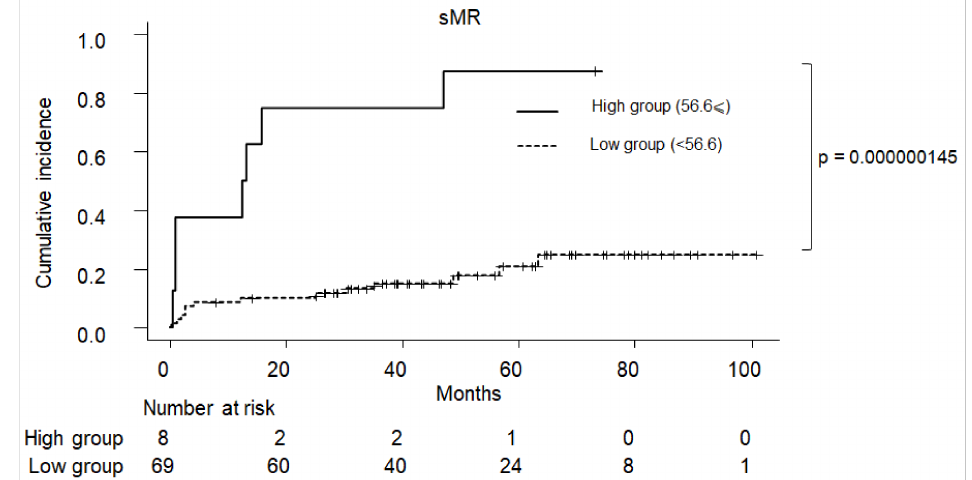
Figure 5. The cumulative incidence of PBC-related complications according to sMR levels. Patients with PBC having a sMR of ≥ 56.6 developed liver-related complications more frequently than those with sMR of <56.6 ( p < 0.01). PBC: primary biliary cholangitis, sMR: soluble mannose receptor.